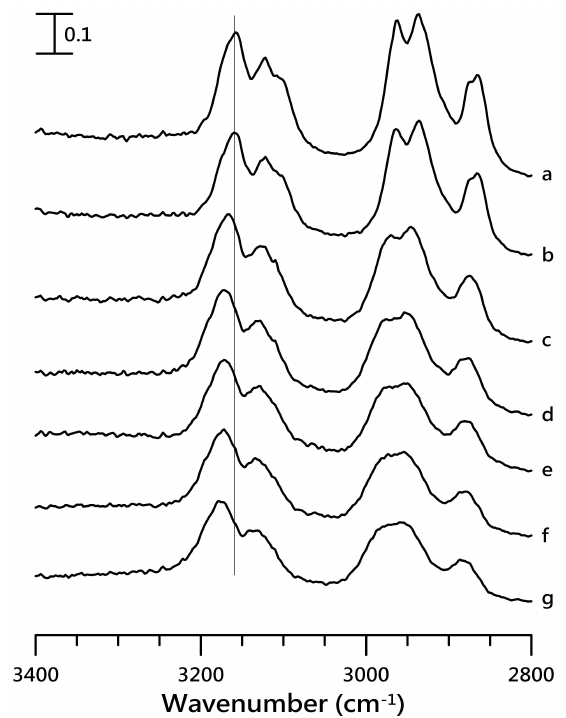
Figure 4. IR spectra of pure [HMIM][NTf 2 ] obtained at ( a ) ambient pressure and ( b ) 0.4, ( c ) 0.7, ( d ) 1.1,